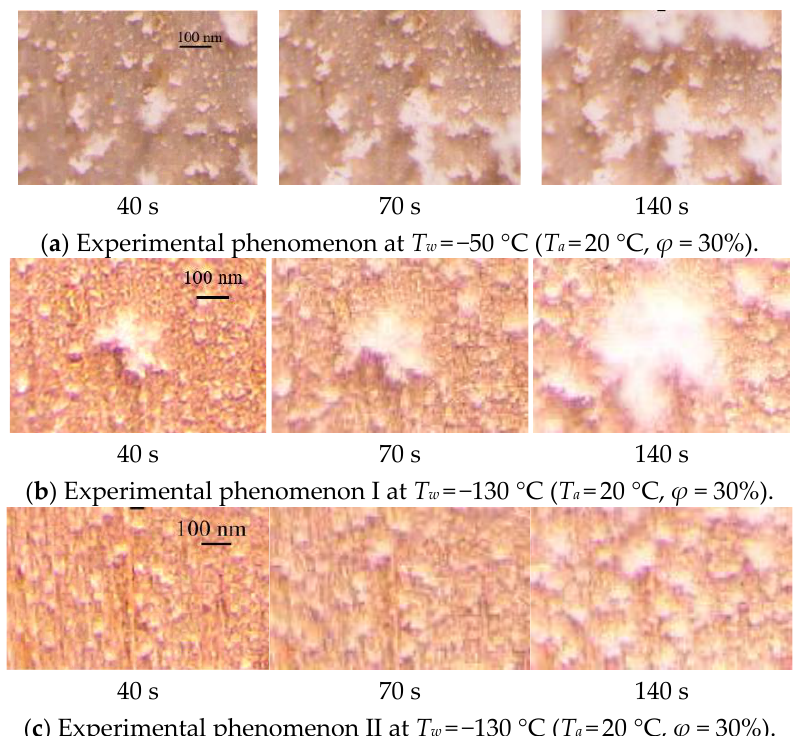
Figure 10. Experimental phenomenon of frosting at three different time instants. Table 1. The measured initial frost layer thickness l h